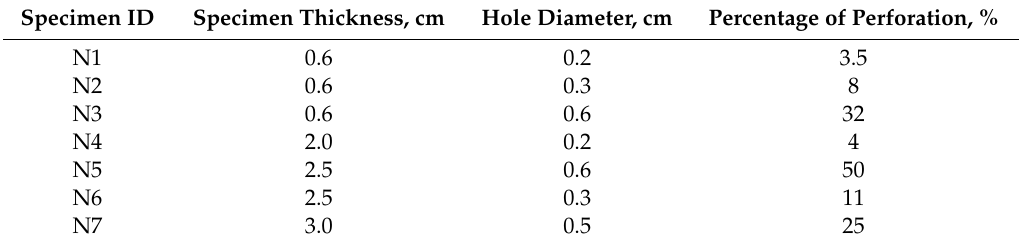
Table 1. Characteristics of the specimens used for the